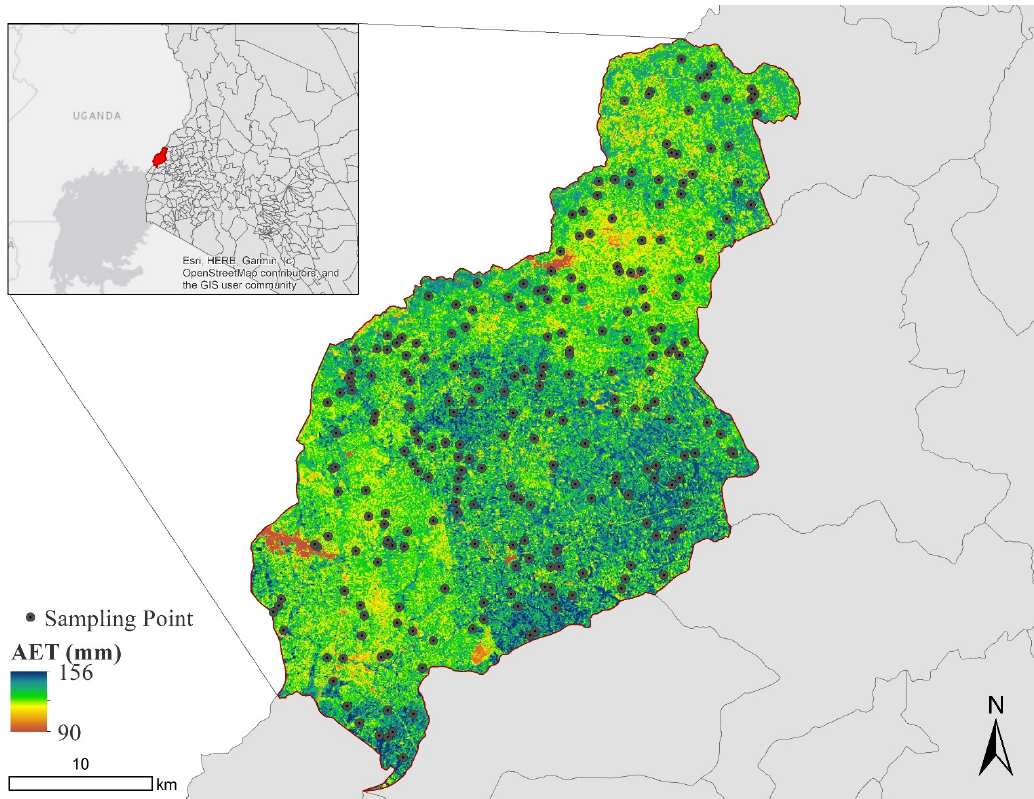
Figure 1. Busia County in western Kenya: The geographic location of the sampling points. The AET raster map was retrieved from the WaPOR official website.